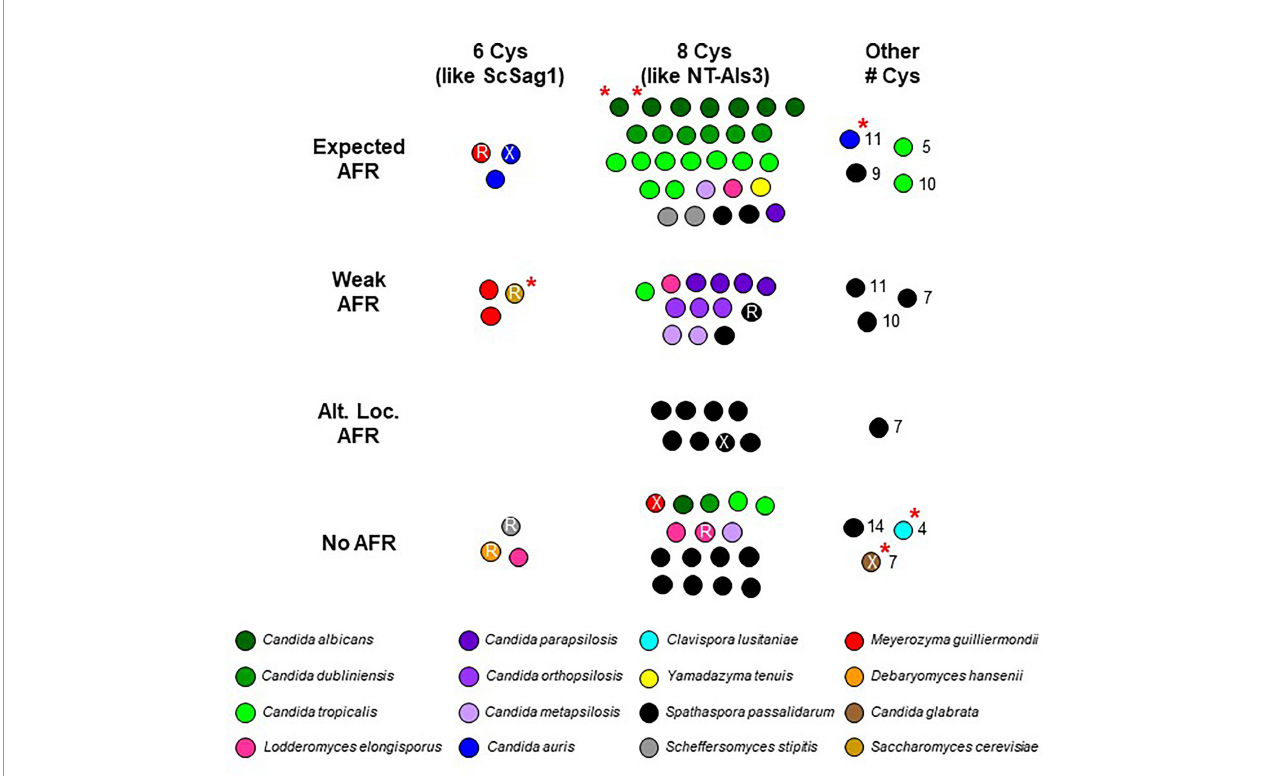
FIGURE 4 | Visualization of NT-Als sequence features from Supplementary Table S2 . Each spot represents an Als protein; color coding matches Supplementary Table S2 . C. albicans NT-Als3 has 8 Cys that create four disul fi de bonds (Lin et al., 2014) while S. cerevisiae Sag1 has only 6 and is missing the C57-C133 disul fi de bond that is present in NT-Als3 (Salgado et al., 2011). Most NT-Als proteins had 8 Cys like NT-Als3 (center column), some had 6 Cys like ScSag1 (left column), and others had varying numbers of Cys (range of 4 to 14; right column). Presence of the amyloid-forming region (AFR) in C. albicans Als proteins promotes protein aggregation (Ho et al., 2019). While many Als proteins had the expected AFR (strength and location; top row), others had a predicted weak AFR (second row) or none (bottom row). Some S. passalidarum Als proteins had a strong AFR 20-30 amino acids C-terminal to the expected location known in C. albicans (third row). It was unknown whether this alternative location contributed to aggregative potential. An invariant Lys in C. albicans NT-Als establishes a salt bridge with the C-terminal carboxylic acid of an incoming peptide ligand (Salgado et al., 2011). Arg (R) in this location may serve a similar function. Some predicted proteins did not have a positively charged amino acid in this position (X). A red asterisk indicates proteins featured in the structural predictions ( Figure 3